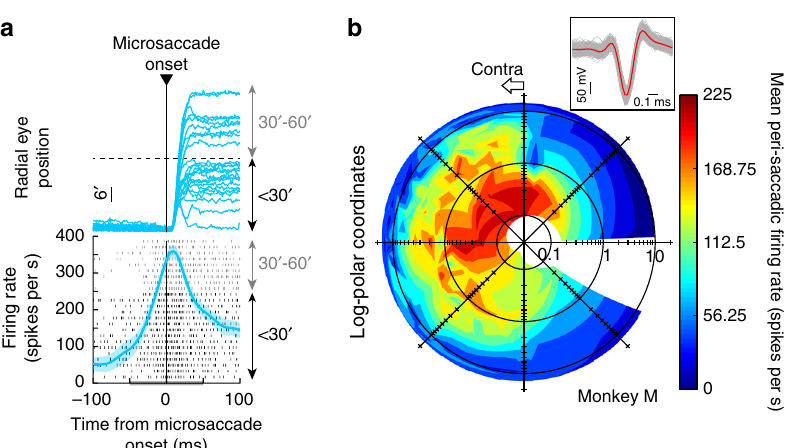
Fig. 6 Superior colliculus (SC) activity during memory-guided microsaccades. a The top panel shows radial eye position aligned on microsaccade onset (for memory-guided microsaccades <1 o ). All traces were aligned to start (on the vertical axis) from the same eye position. Most movements had a radial amplitude <30 min arc (0.5 o ). These movements were selected relative to the response fi eld (RF) as assessed from the analysis in b . The bottom panel shows microsaccade-aligned fi ring rate. Classic SC microsaccade-related activity 18 was observed for memory-guided microsaccades. Each row of tick marks shows the neuron ’ s discharge for an individual movement from the top panel, and the rows are sorted by memory-guided microsaccade amplitude (black for <30 min arc; gray for 30 – 60 min arc). Even the smallest memory-guided microsaccades were associated with SC microsaccade-related discharge 18 . The gray bar on the x -axis indicates the analysis window used in b . Error bars denote 95% con fi dence intervals. b Movement RF of the same neuron. For each movement displacement, plotted in log-polar coordinates 19 , we plotted mean fi ring rate from the measurement interval in a . The neuron, from the right SC, exhibited a movement RF on the contralateral side along an oblique upward direction. The neuron clearly responded for memory-guided microsaccades as small as 0.1° (6 min arc). The origin of the log-polar plot denotes 0.03° radial amplitude. The inset shows spike waveforms from every 100 th spike recorded in the task (gray; 682 waveforms); red shows the average spike waveform (and 95% con fi dence intervals) across all recorded